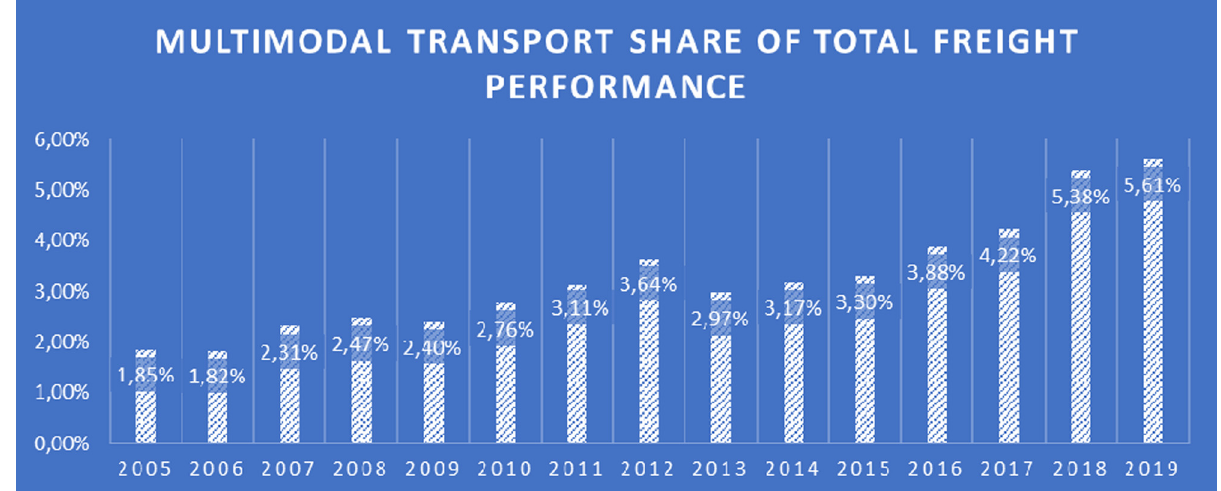
Figure 2: Combined transport share ( in tkm ) of the total freight transport ( % ) . Source: own